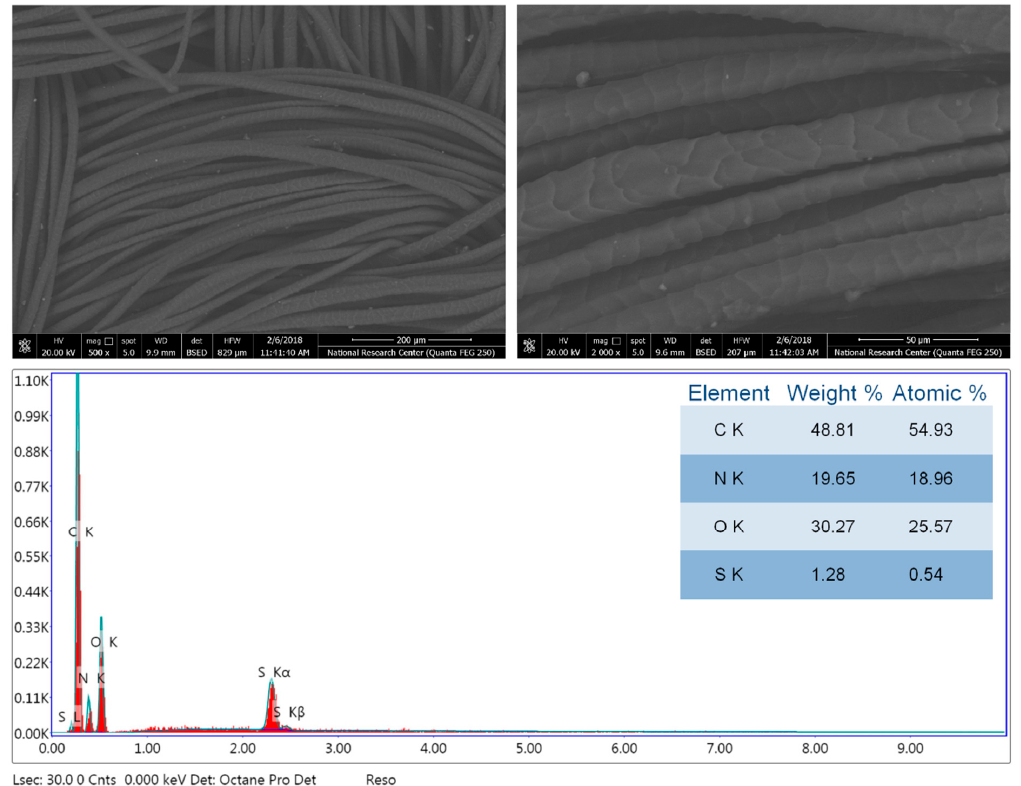
Figure 3. Scanning electron microscope (SEM) images and energy-dispersive X-ray analysis (EDX) diagram of blank/untreated wool fabric.